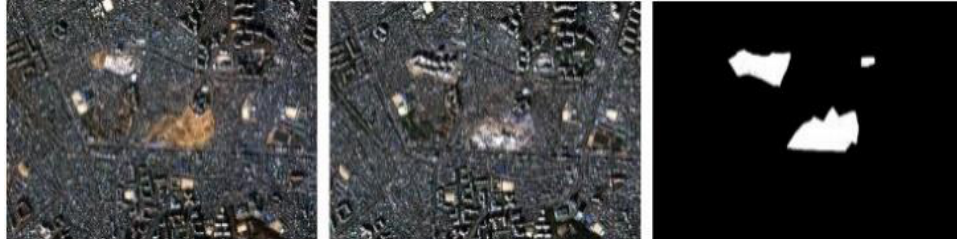
Figure 7. Test area 1 (3232 × 2206): ( left ) Image P, acquired in March 2014; ( middle ) Image C, ac- quired December 2015; ( right ) Ground truth. Figure 6. Dataset generation: ( Left ) Image P, acquired in March 2014; ( middle ) Image C, acquired December 2015; ( right ) Ground truth.